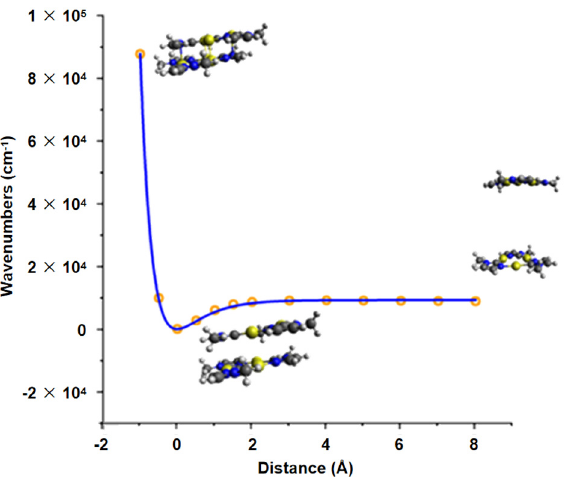
Figure 4. Results of the PES scan of the distance between two Au 3 (MeIm) 3 -{Monomer} in Au 3 (MeIm) 3 -{Dimer}. The inset shows three structures ( − 1 Å , 0 Å and 8 Å ) at different distances. Note that we fitted a Morse potential to the single scan points for the extraction of D e (Orange circle: electronic energies from SP-DFT; blue line: fitting curve with function D e (1-exp(a(r-R e ))) 2 and R 2 = 0.99976; the R e value was set to 0 and the energies were corrected by the lowest energy structure).